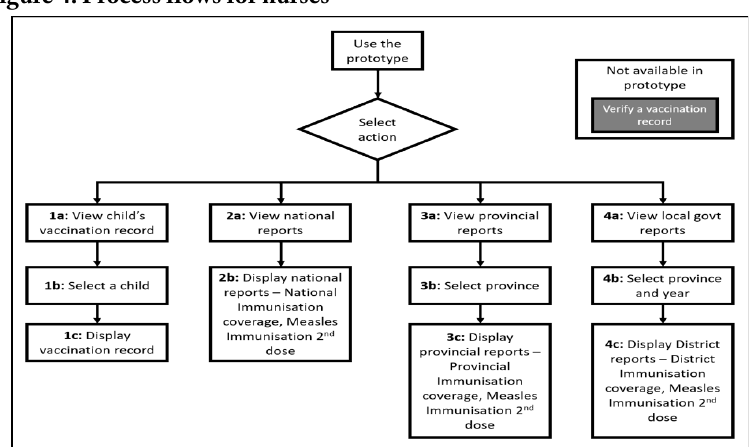
Figure 4: Process flows for